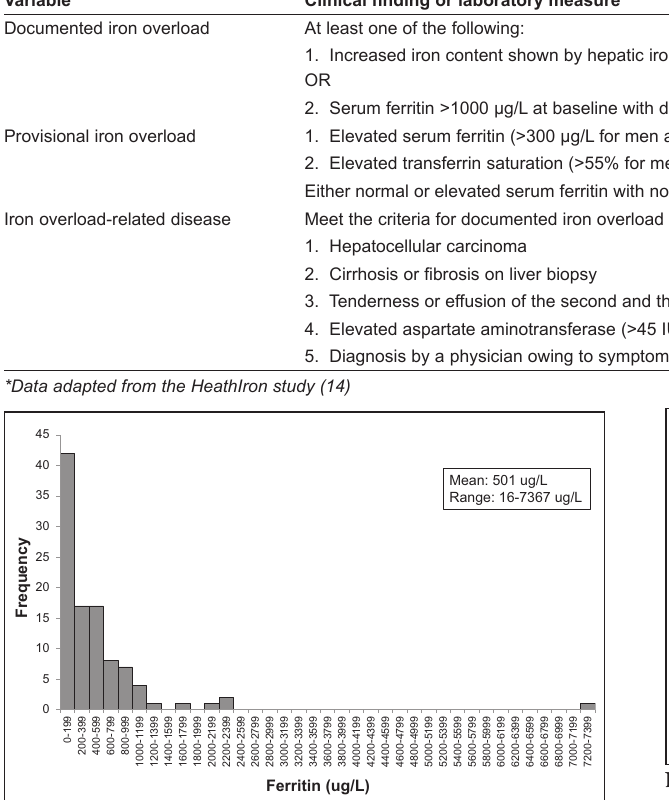
TABle 1 Iron overload categories* Variable Clinical finding or laboratory measure Documented iron